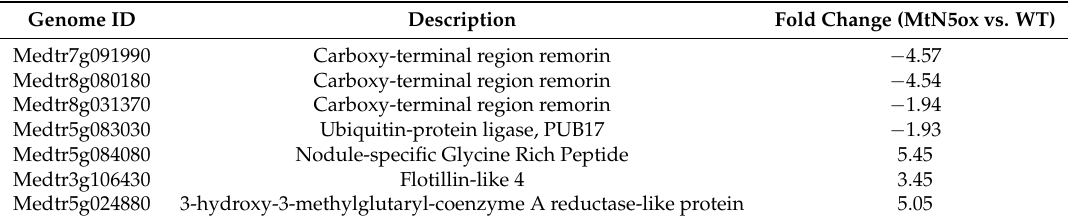
Table 2. Differentially expressed transcripts known to be involved in the nodulation process and discussed in the